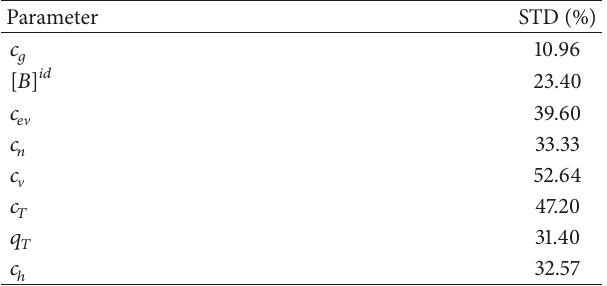
Table 10: Standard deviation (STD) of the estimated parameters, regarding fitting to individual trajectories compared to their nomi- nal value in